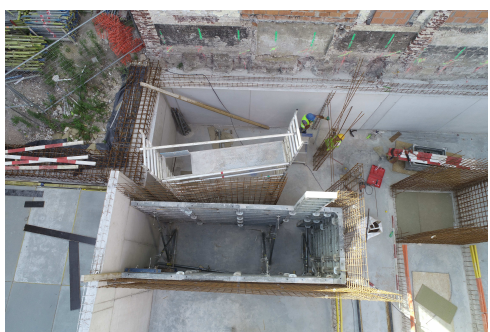
Figure 5: Dark or poorly illuminated spaces and spaces with a large variety in exposure are challenging to record to cover the complete scene is heavily reduced, but with a lower level of detail. Secondly, an approach using wide-angle or